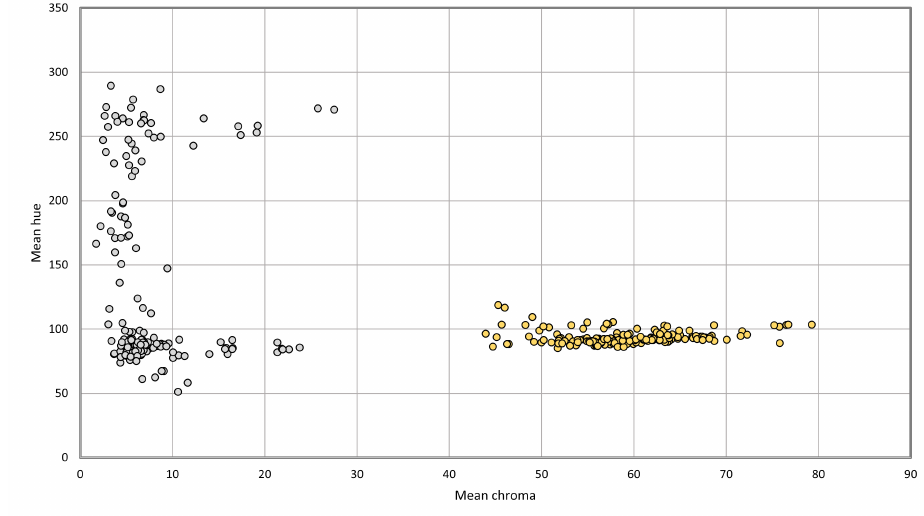
Figure 5. Data distribution of mean Hue and Chroma values for DT (grey) and CT (yellow).